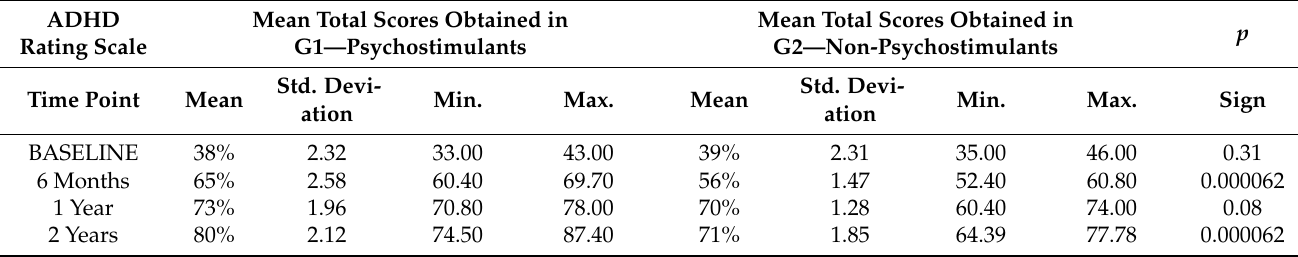
Table 5. Comparative analysis between group 1 with psychostimulants and group 2, concerning the Children’s Global Assessment Scale (CGAS) scale scores, in different time